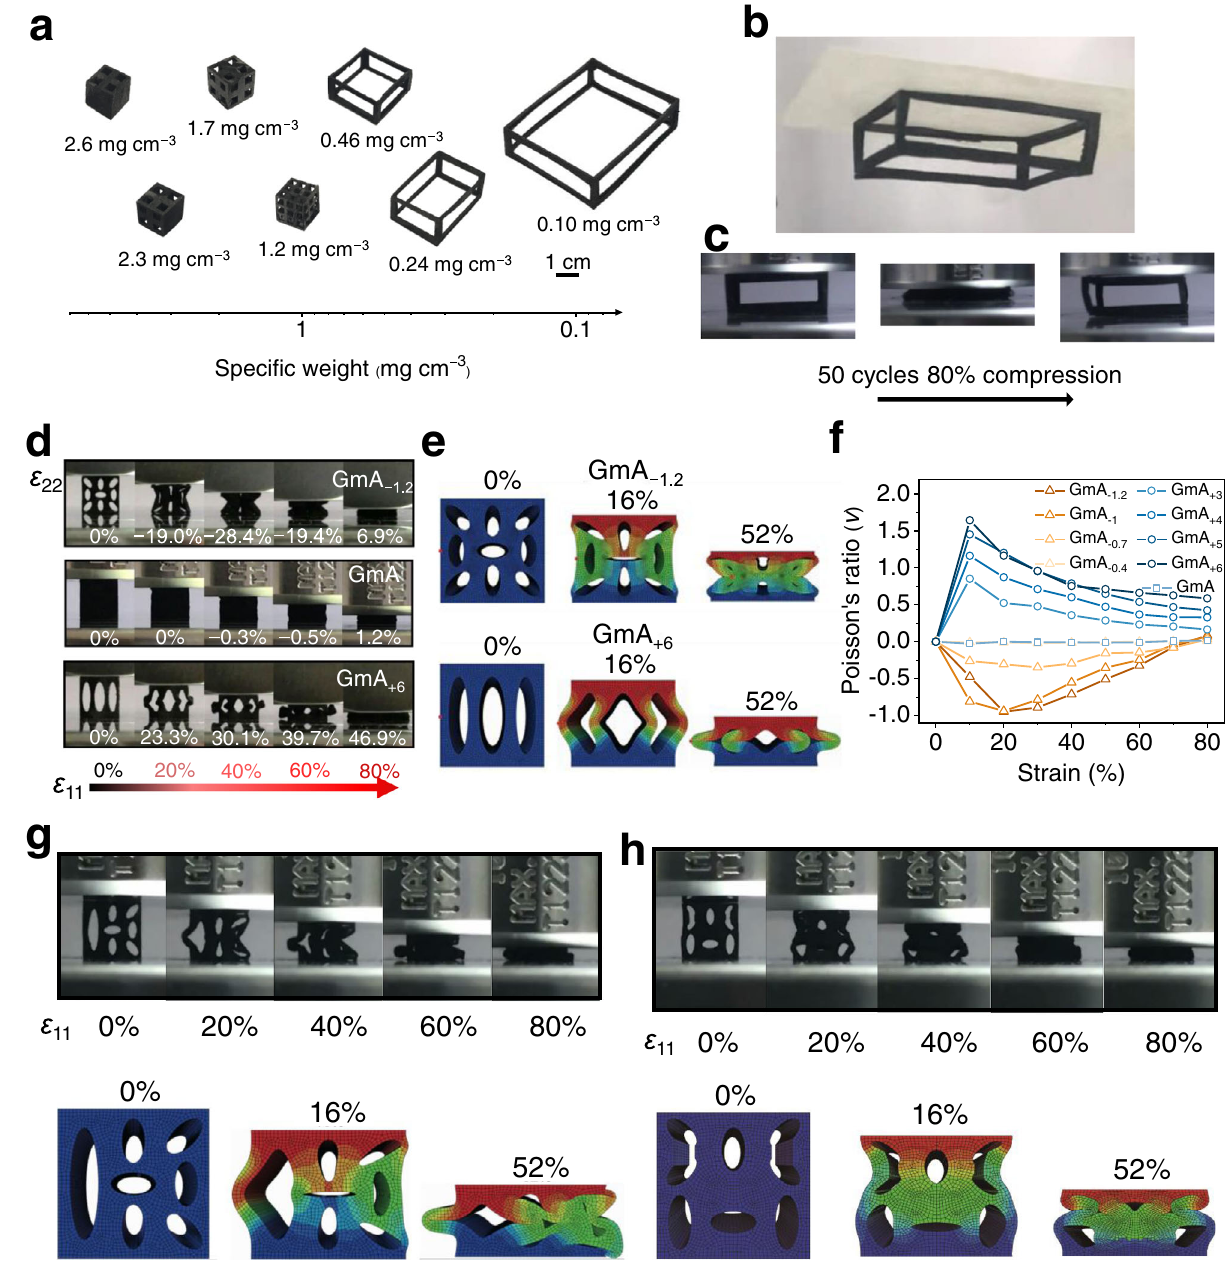
Fig. 6 | Laser engineering meta-structures of GmAs with appealing properties. a Thespeci fi cweightdistributionsofGmAsafterlaser-engraving.Thepicturesgive speci fi cweightandshapesofdifferentGmAs. b aGmA(3.3cm×2.7cm×1cm)with theultralightspeci fi cweightof0.1mgcm − 3 canovercomethegravityrelyingonthe electrostaticforce. c PhotographsoftheGmA(3.3cm×2.7cm×1cm)withspeci fi c weight of 0.1mgcm − 3 before and after 50 compression cycles at 80% strain. d The snapshotsofGmAs(0.8cm×0.5cm×0.8cm)withdifferentcon fi gurationsduring uniaxial compression, The snapshots of GmAs (0.8cm × 0.5cm × 0.8cm) with different con fi gurations during uniaxial compression, concave-shaped con fi gura- tion(GmA − 1.2 )(upperrow),pristinecon fi guration(GmA)(middlerow),andconvex- shaped con fi guration (GmA +6 ) (lower row). e The fi nite element calculation shows